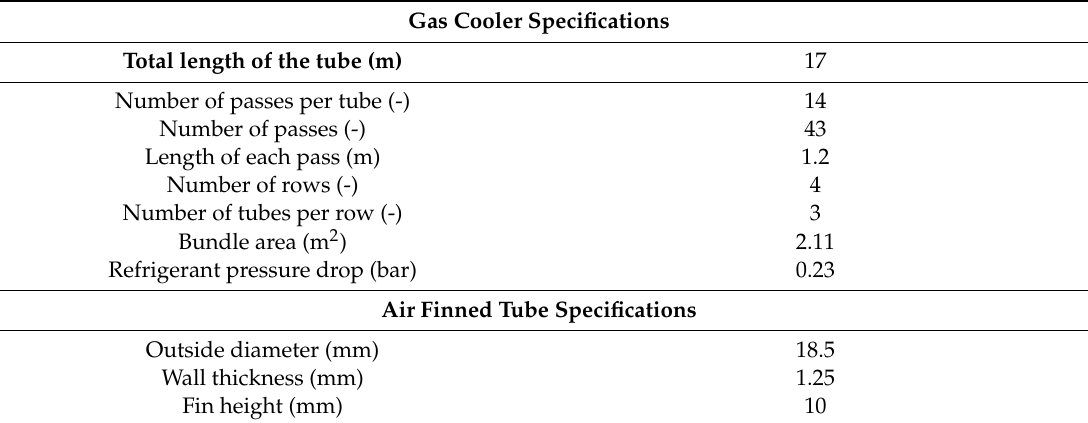
Table 4. Gas cooler technical specifications.